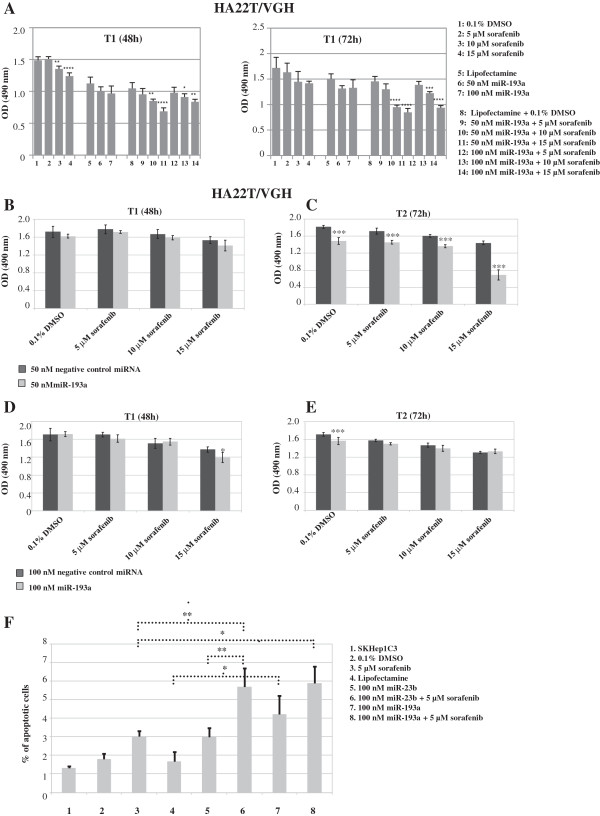
Effects on cellular proliferation and apoptosis of combined treatment with sorafenib and miR-193a/miR-23b in HCC cell lines. (A) The MTT assay showed that the growth of the HA22T/VGH cells was significantly reduced after the combined treatments of sorafenib plus miR-193a. *p < 0.05; **p < 0.01, ***p < 0.001, ****p < 0.0001 in a one-way ANOVA followed by Bonferroni correction: for sorafenib alone versus 0.1% DMSO, for miR alone versus Lipofectamine, for the co-treatments versus Lipofectamine plus 0.1% DMSO. (B-E) The HA22T/VGH cells were transfected with negative control miRNA or miR-193a and treated with either vehicle (0.1% DMSO) or different concentrations of sorafenib (5-10-15 μM). Two-way ANOVA followed by Bonferroni correction was used to establish whether significant difference existed between negative control miRNA transfected cells and miR-193a transfected cells; ***p < 0.001. (F) TUNEL assay in SKHep1C3 cells. The cells transfected with 100 nM miR-23b or miR-193a and then treated with 5 μM sorafenib showed increased percentages of apoptotic cells (up to 1.95 times those of cells treated with sorafenib alone). *p < 0.05; **p < 0.01 in a two-way ANOVA followed by Bonferroni correction.